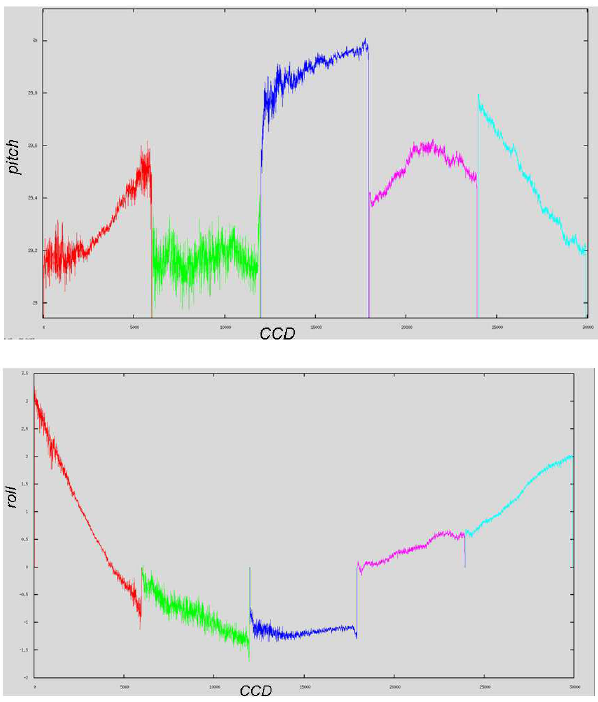
Figure 11: Pleiades-HR staggered focal